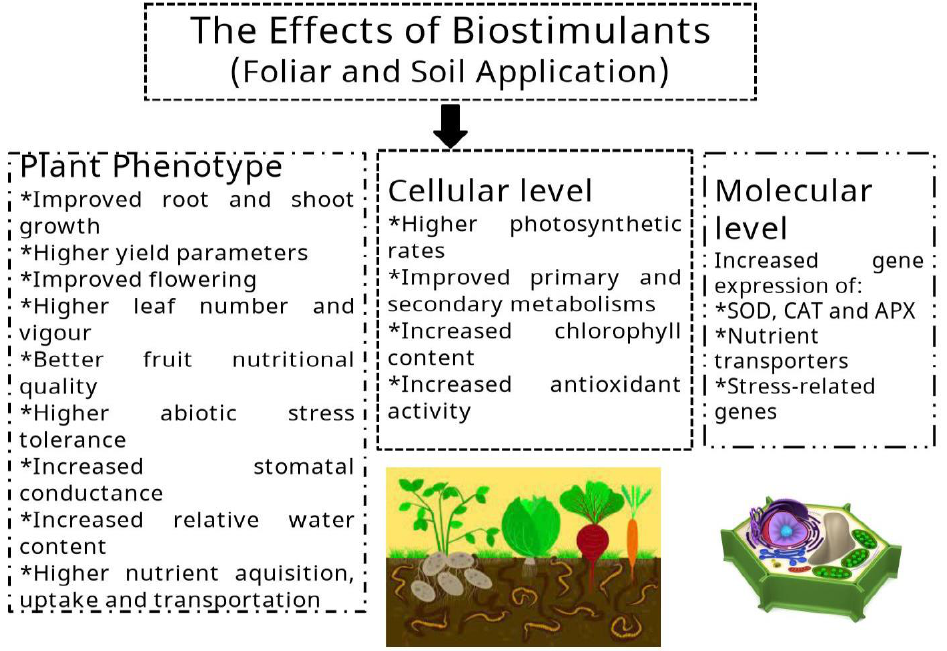
Figure 2. The most notable impacts of different biostimulants on plant phenotype, cellular level and molecular